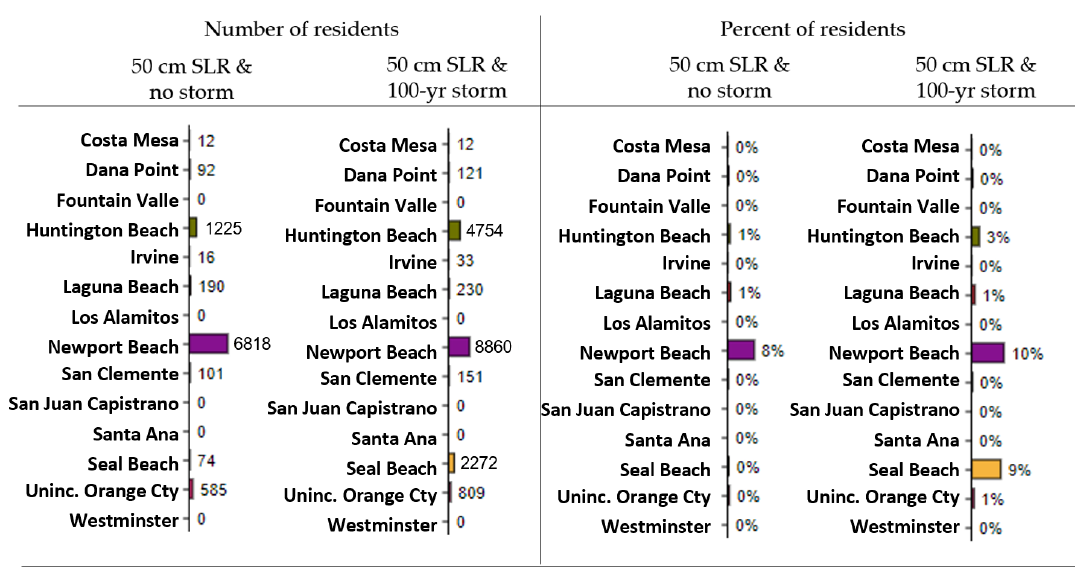
Figure 6. Example outputs (screen-grab: https://www.usgs.gov/apps/hera/) from the Hazard Exposure and Analytics (HERA) web tool comparing the number and percent of persons in each community that reside within the flood hazard zone for the 50 cm SLR with and without the projected 100-year coastal storm. Example is for Orange County.